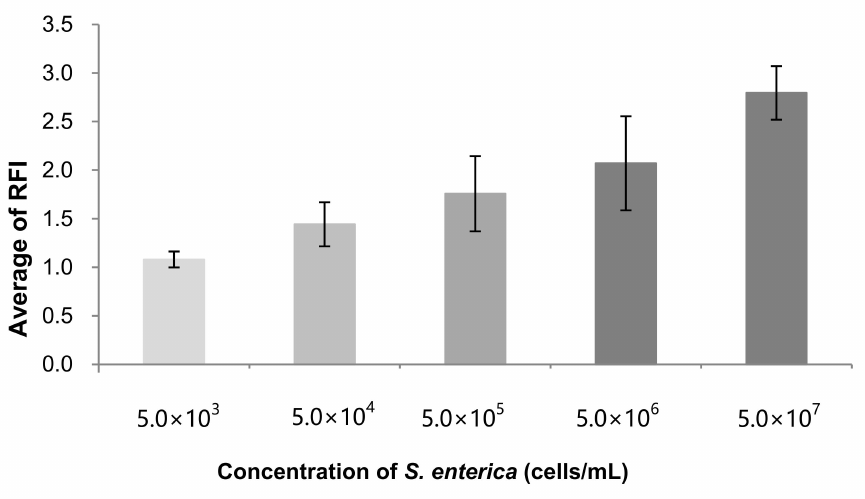
Figure 6. Concentration dependence of S. enterica cells on average